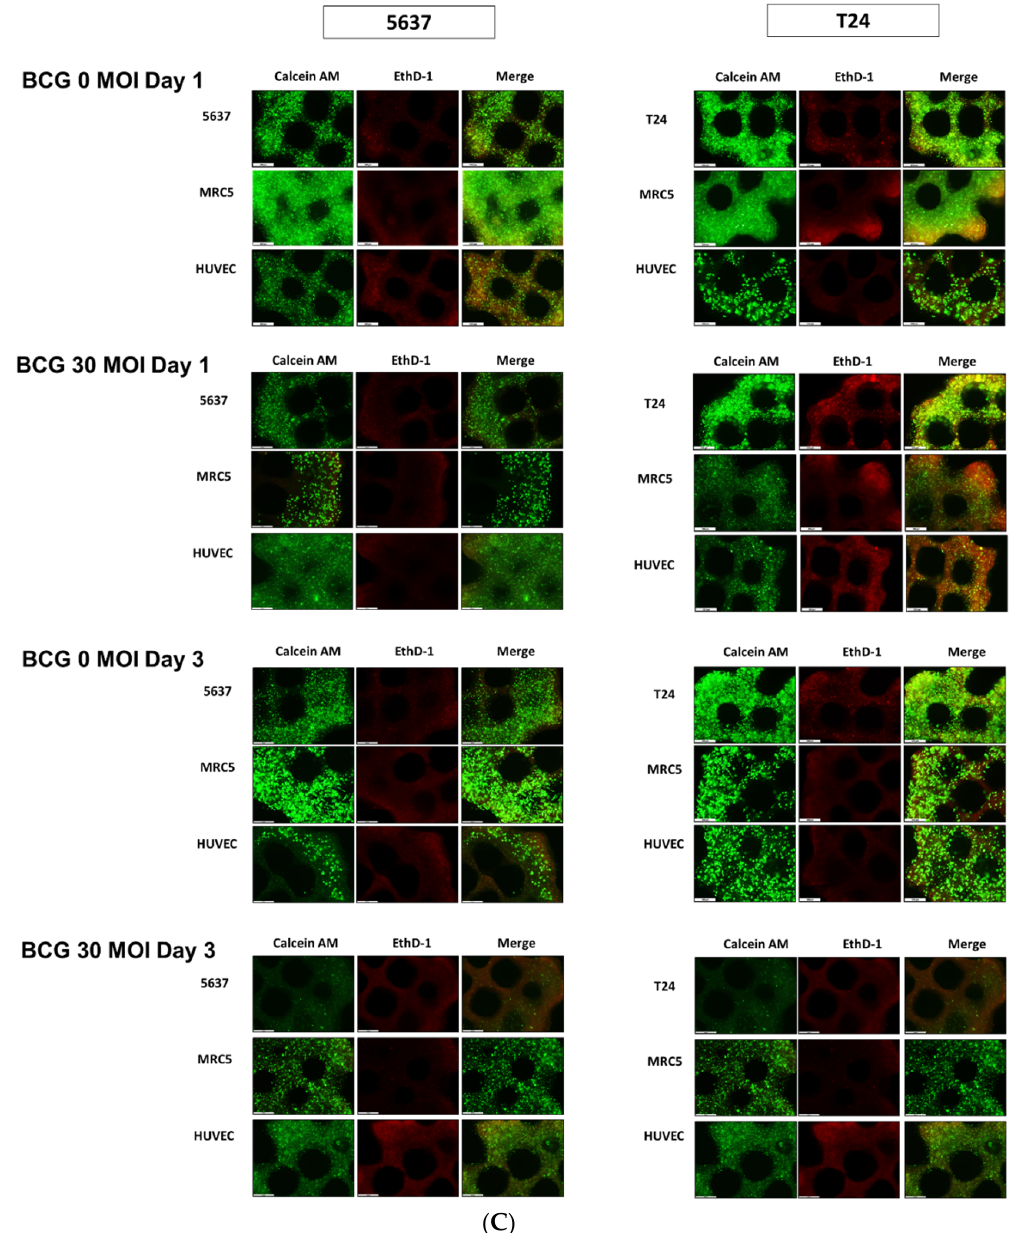
Figure 1. Performance validation of bladder cancer-on-a-chip. The cells were stained with green (live) and red (dead) colors. (Scare bar = 500 μ m) ( A ) the GelMA structure and cell viability on BCOC according to structural filling density; ( B ) cell viability on BCOC according to microfluidic velocity; ( C ) bladder cancer cell viability at three days after BCG treatment in BCOC.